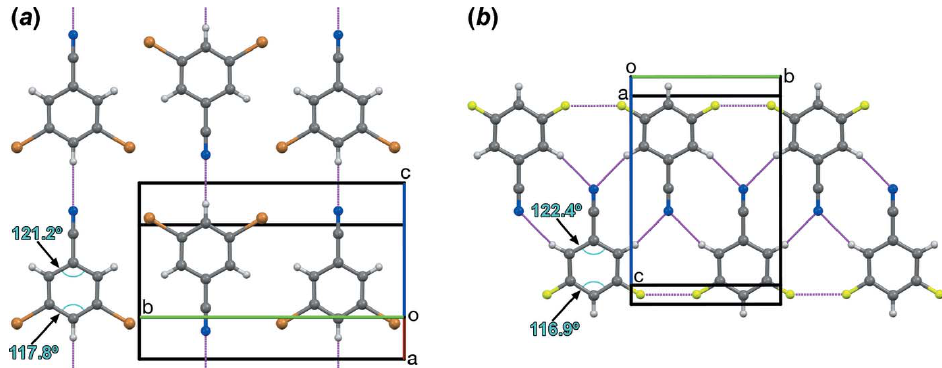
Figure 2 The sheet structures in crystals of ( a ) compound (I), viewed along [301]; ( b ) 3,5-difluorobenzonitrile, viewed roughly along [100]. Bond angles about the ortho and meta C atoms are denoted in light blue. Dashed magenta lines represent short contacts.